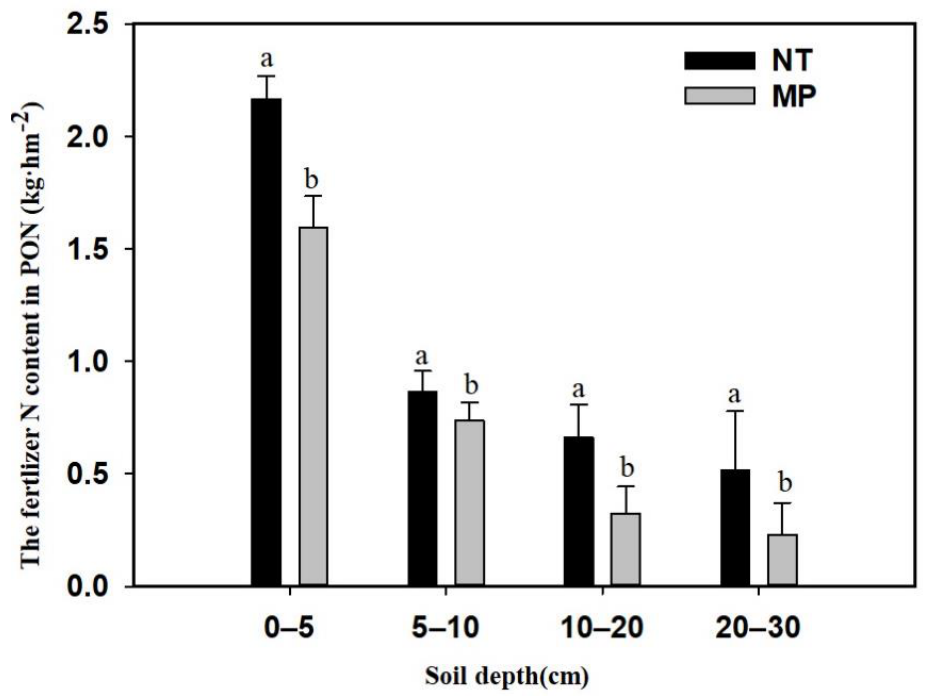
Figure 2. Depth distributions of fertilizer N in PON.